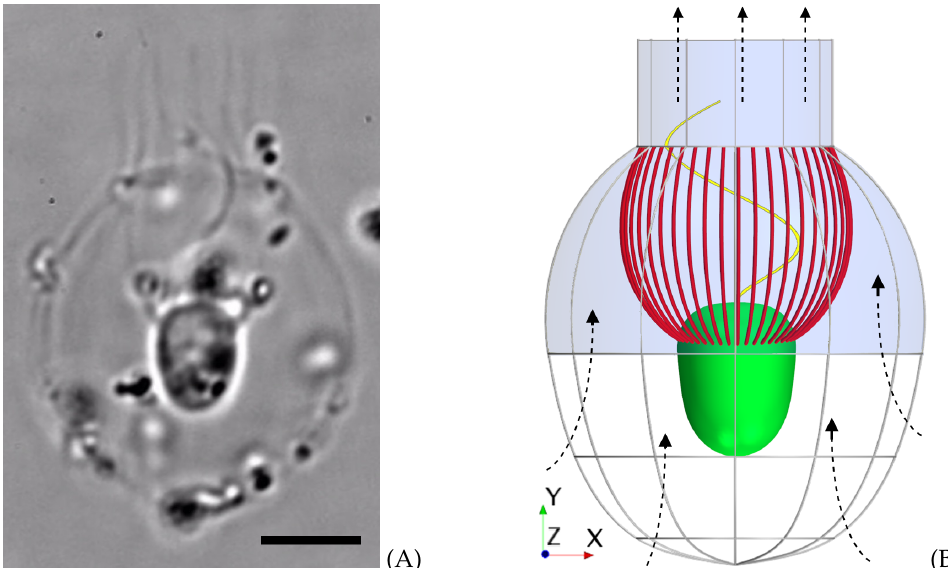
Figure 1. Morphology of Diaphanoeca grandis . ( A ) Microscopic image of the choanoflagellate. Scale bar: 4 µ m. ( B ) Model morphology picturing the cell (green), collar filter (red), flagellum (yellow), and lorica dome and chimney (blue) with ribs (gray) in the lower part of the lorica. The direction of the flow is indicated with the dashed